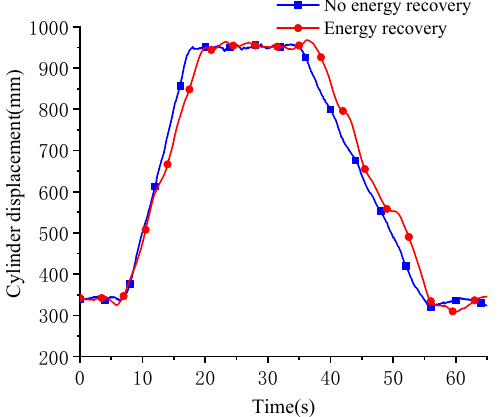
Figure 31. Displacement of the cylinder in these two systems.